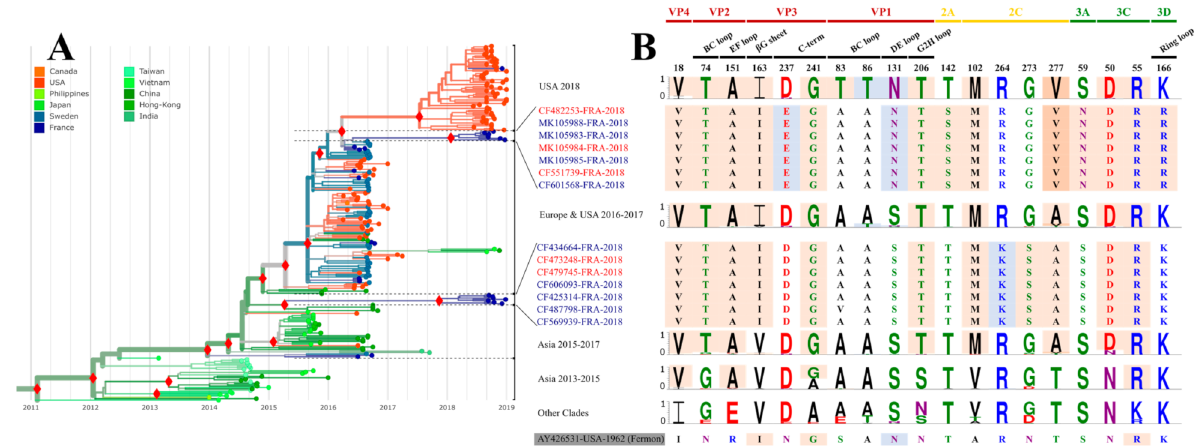
Figure 3. Phylogeny of EV-D68 clade B3 and molecular variation of viral proteins. ( A ) The phylogenetic tree was obtained with the Nextstrain pipeline using a global dataset of 734 EV-D68 whole genomes available in Genbank (as of 1 February 2020) and 30 new sequences obtained in this study. The solid red diamonds indicate statistical support of main nodes (posterior probability ≥ 0.98). The colours of sequence names match with age groups of related patients: red and blue colours match with adults (>16 years) and children ( ≤ 16 years), respectively. Sequence names in black had no corresponding information on related patient age. The branches are coloured according to the geographic origin. ( B ) Identification of protein positions having amino acid residues specific to clade B3. The amino acid positions from other EV-D68 clades are expressed in percentages on the graph with Weblogo 3 [14]. Amino acids with pink background indicate specific positions. Amino acids with blue background match unspecific positions. Amino acids are coloured according to their